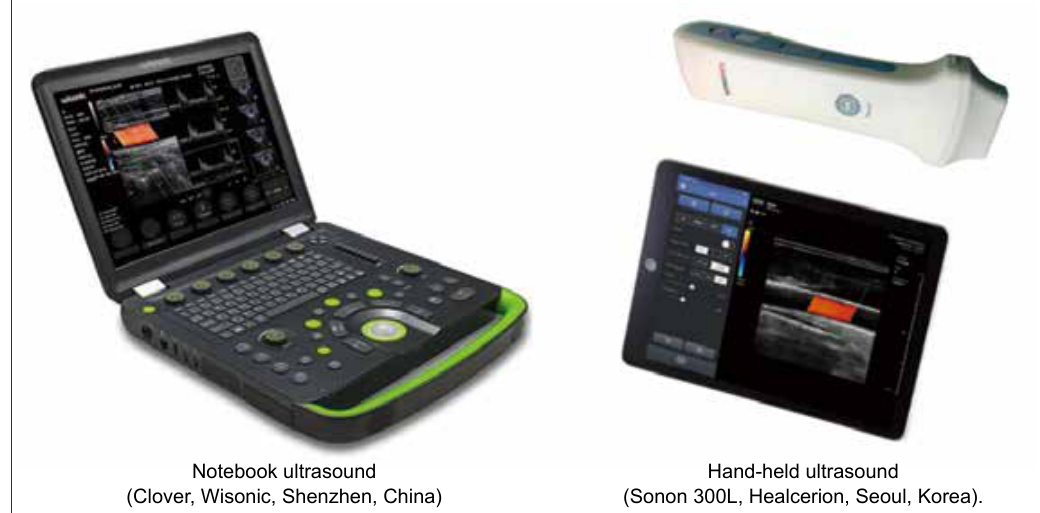
Figure 1 Portable ultrasound equipment.